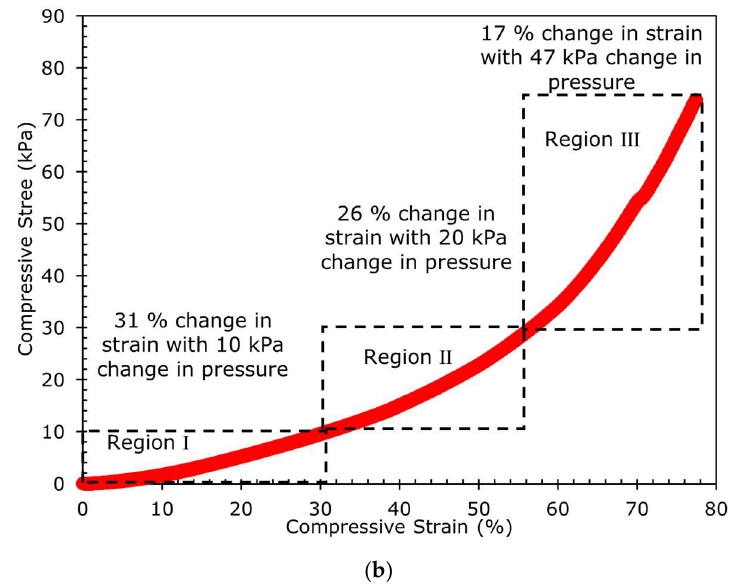
Figure 7. A band diagram showing the Schottky/thermionic emission in Region I.